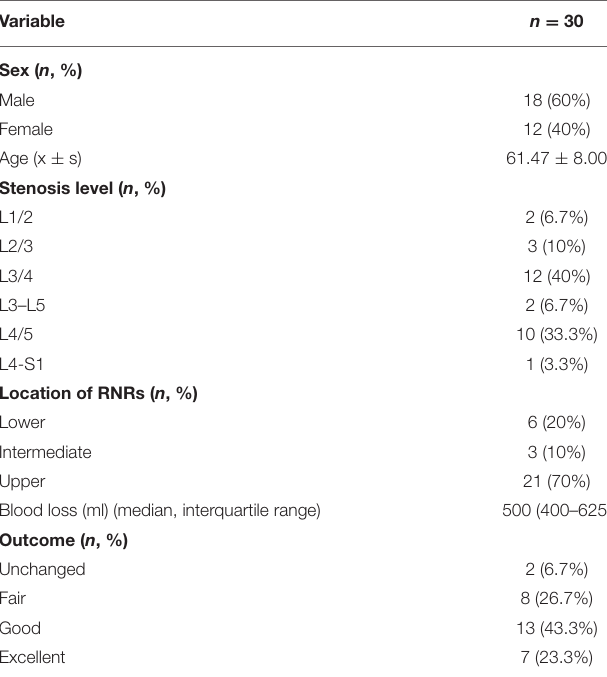
TABLE 2 | Patient